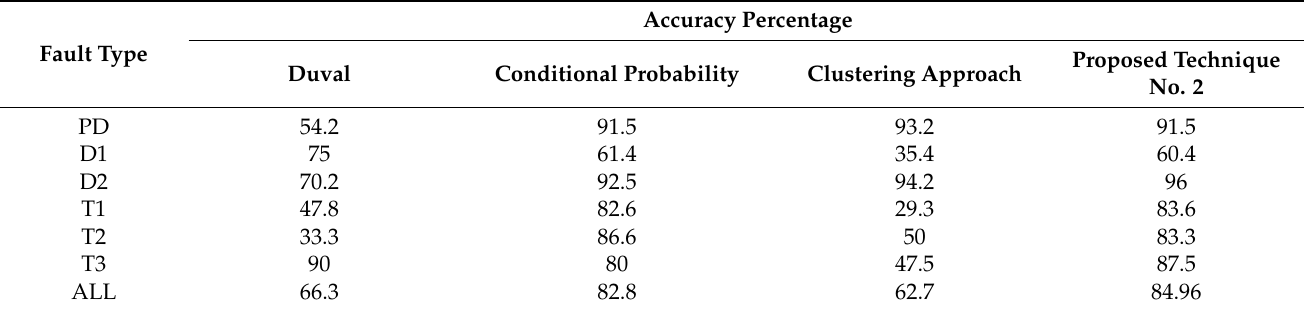
Table 3. Accuracy percentages of the modified technique and the three